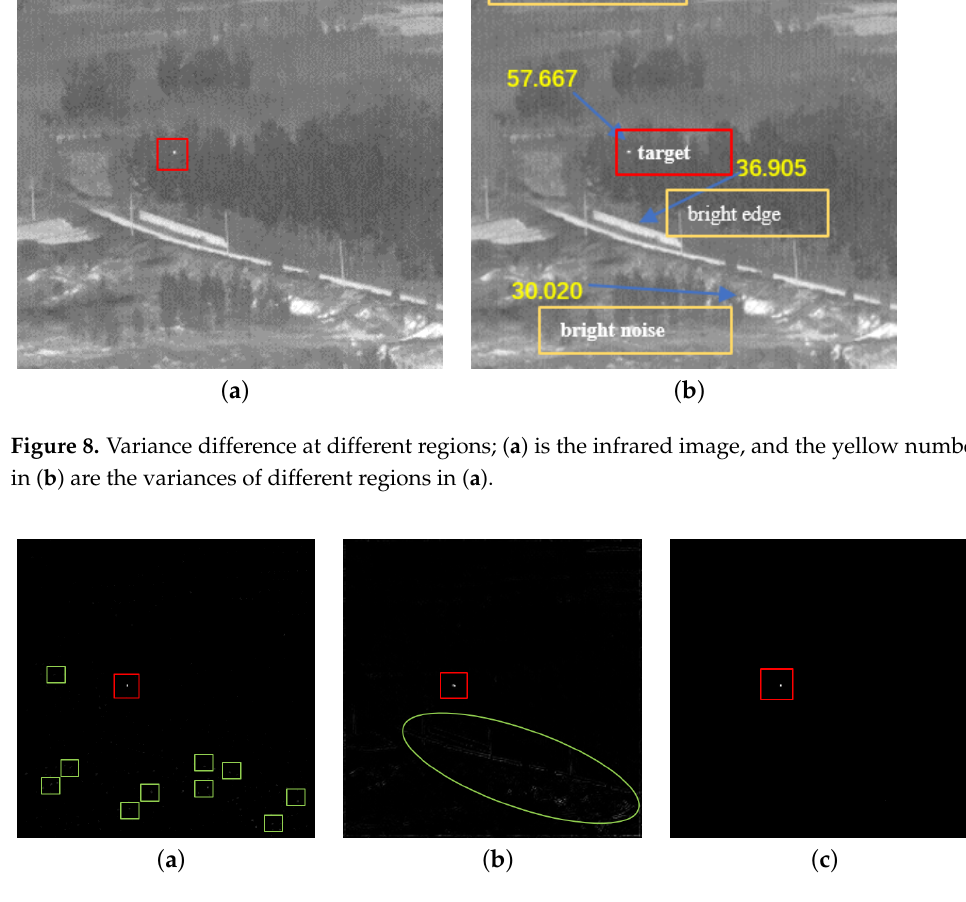
Figure 9. The effect of the proposed method. ( a ) is the PRT obtained by the LCF, ( b ) is the PRT obtained by the LV, and ( c ) is the PRT obtained by the proposed algorithm. The red marks are the target components that we want to highlight. The green marks are false alarm components that we do not want to